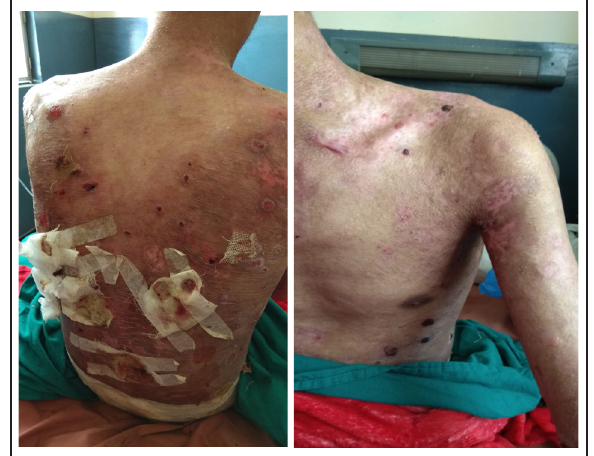
Figure 1A. Multiple vesicles and bullae with erosions and hemorrhagic crusts measuring approximately 0.5x0.5 cm to 3x5 cm over back. Ruptured blisters are covered with dressing. Hypopigmented areas seen at the sites where previous lesions have healed. Figure 1B. Crusts over few lesions on left shoulder, arm and abdomen with hypopigmentation over areas of previously healed